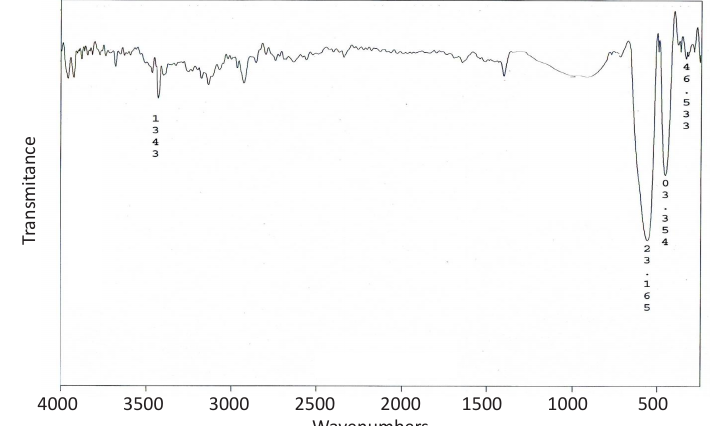
Fig. 6. FT-IR spectrum of Fe